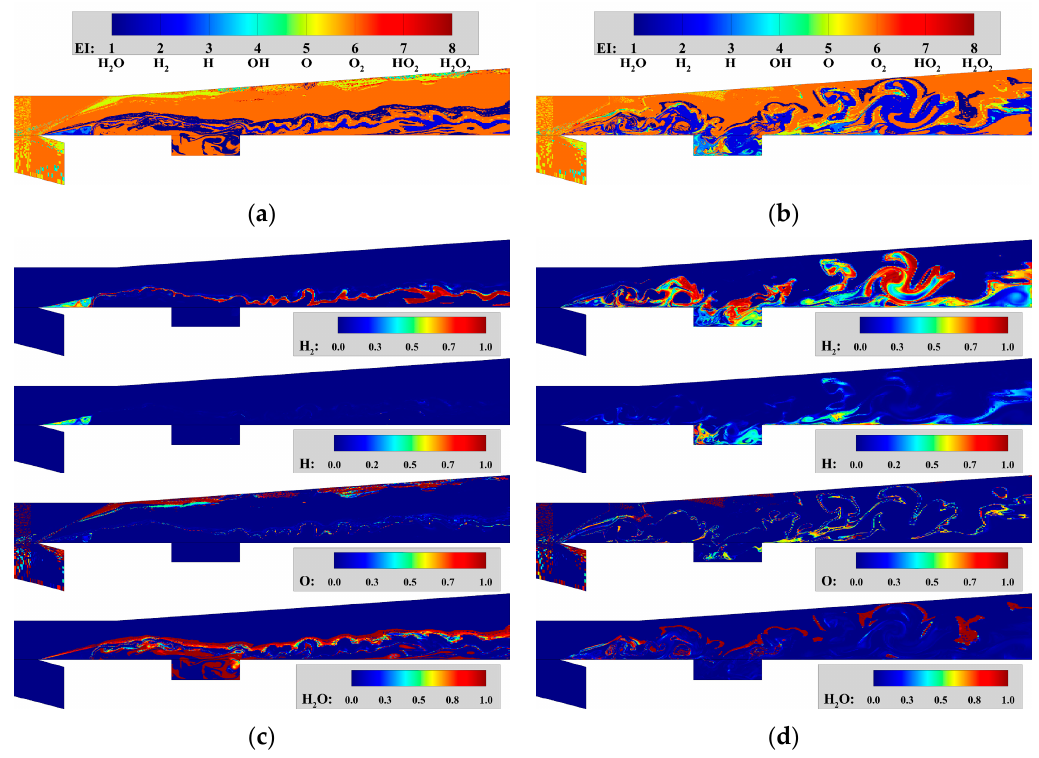
Figure 9. Results of the chemical mode explosive analysis for each injection pressure case: dominant EI results for ( a ) 0.75 MPa and ( b ) 1.0 MPa; normalized EI results for ( c ) 0.75 MPa and ( d ) 1.0 MPa.